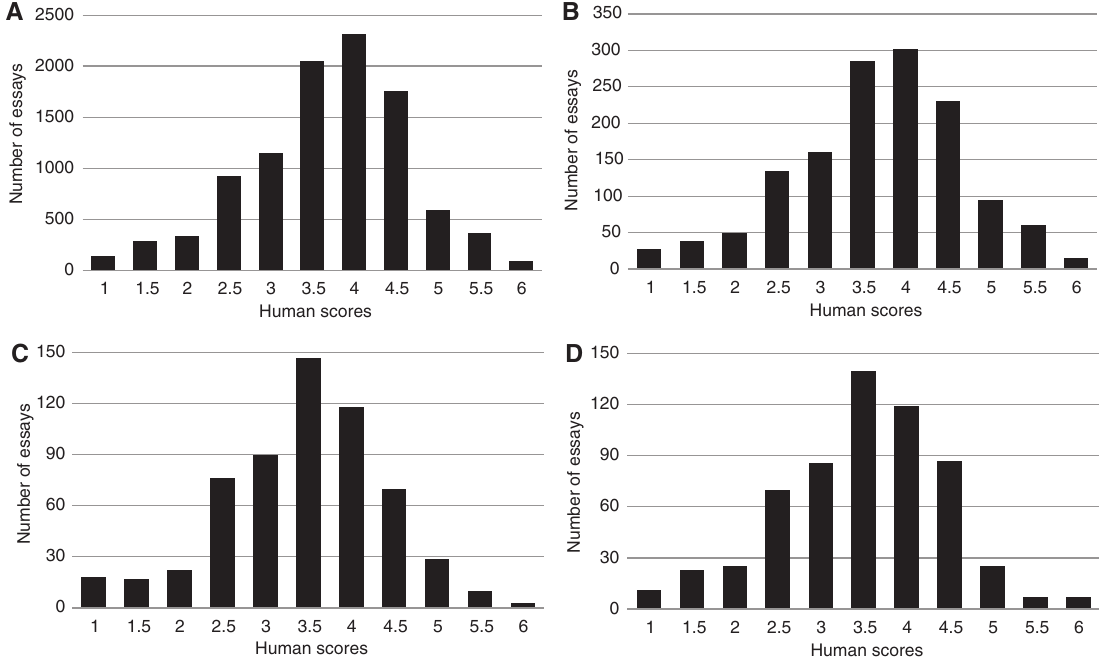
Figure 13: The Human Score Distributions of Training Set 1 (A), Training Set 2 (B), the Validation set (C), and the Testing Set